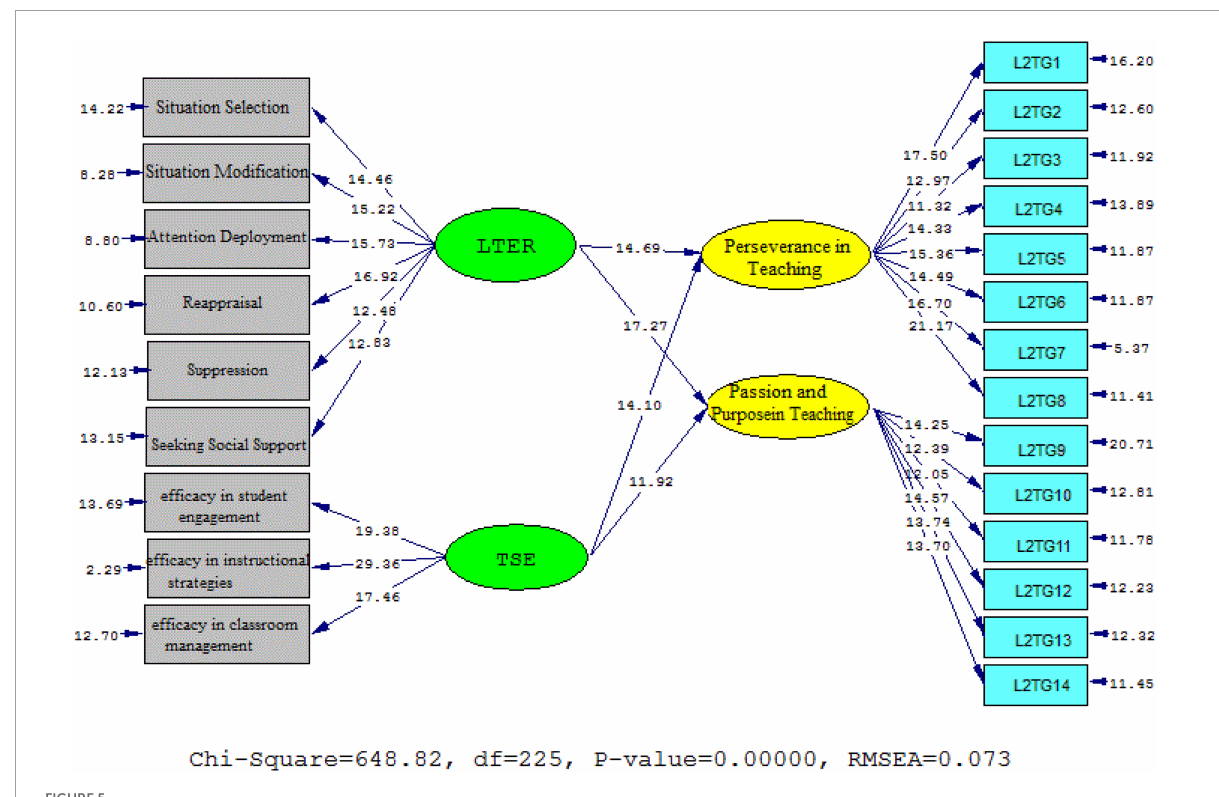
FIGURE5 T -values for path coefficient significance (model 2).